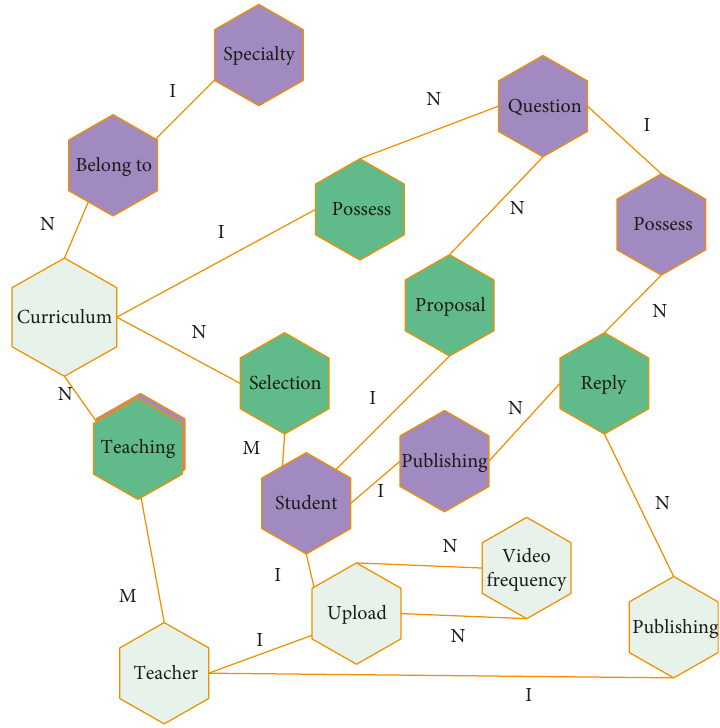
Figure 6: System E-R